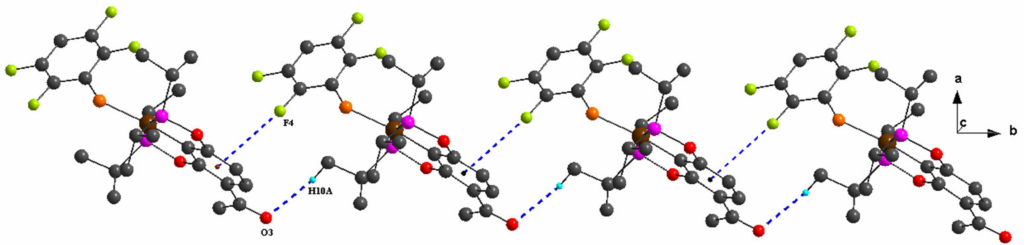
Figure 3. Representation of the chains formed by the F4 ··· Cg(C1–26) and C10–H10A ··· O3=C7 interac- tions. The H atoms not involved in these interactions have been omitted for clarity.